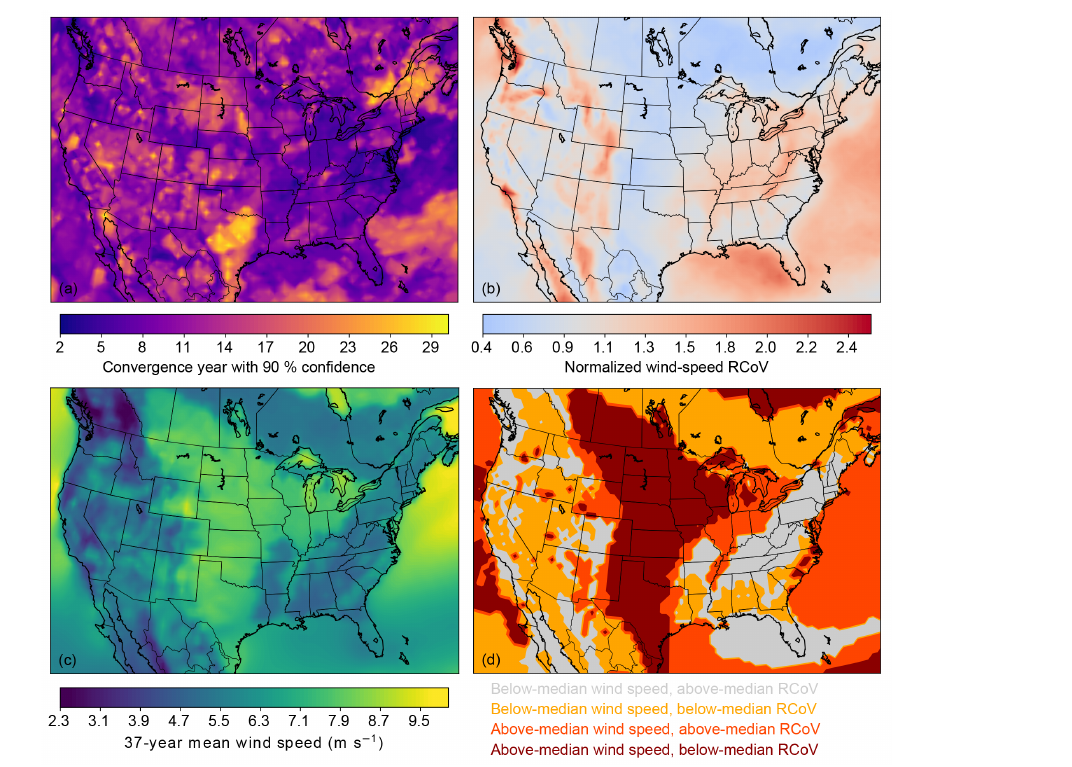
Figure 10. (a) Map of the convergence years, or years of monthly mean wind-speed data required to derive a maximum of 10% deviation from the 37-year RCoV at each grid point, at a 90% confidence level. The CONUS median is 10 years with the MAD of 3 years; (b) map of RCoV of monthly mean wind speed using the grid-cell-specific convergence years in (a) , normalized using the CONUS RCoV median at 0.100. The RCoVs illustrated are averaged over (37 − convergence year + 1) available year blocks. The MAD of the normalized RCoV in the CONUS is 0.224; (c) map of the mean monthly wind speed at 80m of 37 years from 1980 to 2016. The CONUS median is 6.45ms − 1 with the MAD of 1.03ms − 1 ; (d) map of wind resource and its variability, by summarizing (b) and (c) into four categories: regions with below- median wind speed and above-median RCoV (grey), regions with below-median wind speed and below-median RCoV (orange), regions with above-median wind speed and above-median RCoV (orange red), and regions with above-median wind speed and below-median RCoV (dark red), based on the CONUS median wind speed and